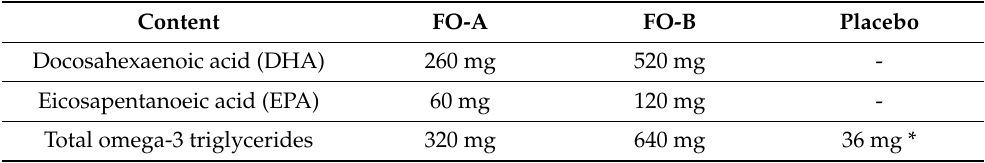
Table 2. Nutritional content of study investigational products. Content FO-A FO-B Placebo Docosahexaenoic acid (DHA) 260 mg 520 mg - Eicosapentanoeic acid (EPA) 60 mg - Total omega-3